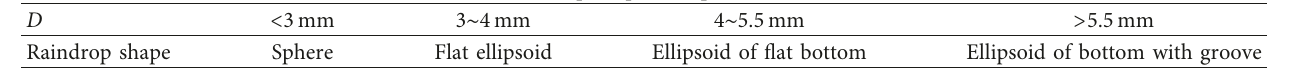
Table 1: Raindrop shape vs. equivalent